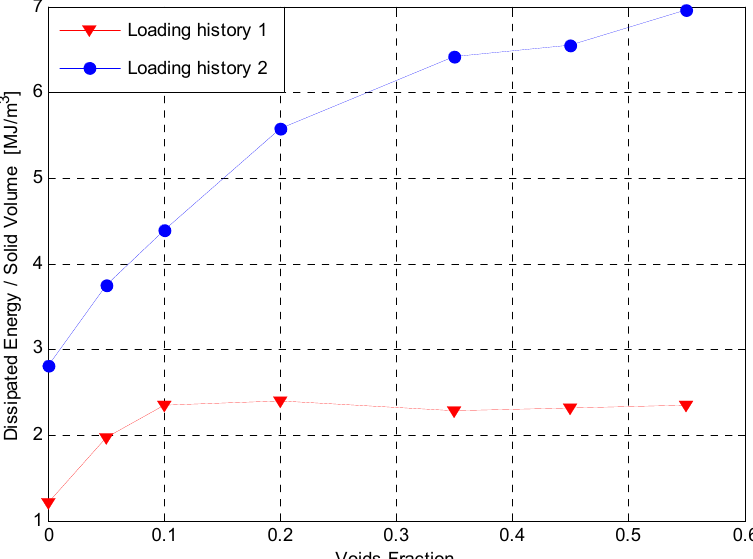
Figure 5: Dissipated energy per solid volume for the considered porosities provided by the two loading histories.